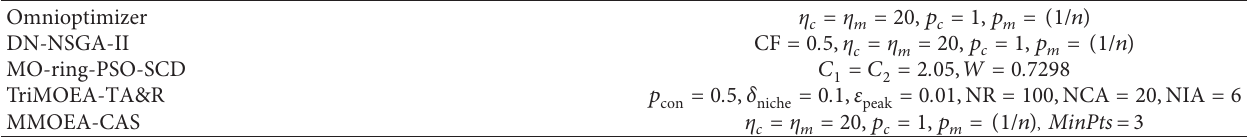
Table 1: Parameters setting of all compared algorithms.